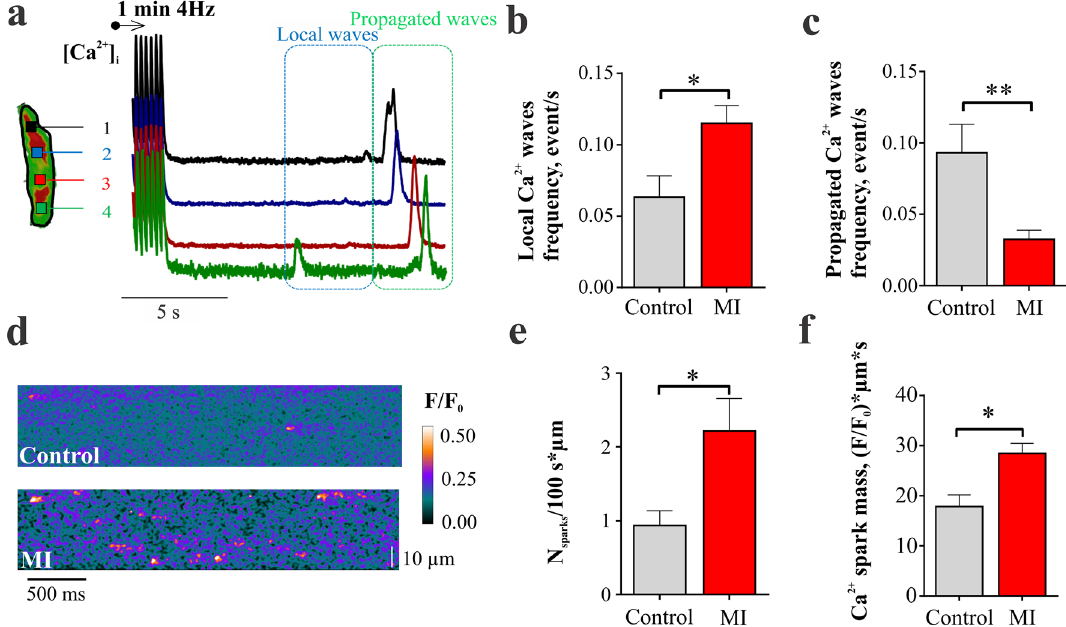
Figure 3. Spontaneous Ca 2+ activity in MI versus control RVMs. (a) Illustration of the spontaneous Ca 2+ waves recorded in control and MI RVMs. Myocytes were paced for 1 min at 4 Hz to enhance SR Ca 2+ loading, then the spontaneous Ca 2+ activity was recorded during 16 s after the pacing cessation. Propagated and local Ca 2+ waves were analysed separately. (b) Analysis of local and (c) propagated Ca 2+ wave frequency in control and MI RVM. Control n = 10 cells from 4 rats, MI n = 13 cells from 4 rats. **P < 0.01, by unpaired Student t test. (d) Line-scan images of Ca 2+ sparks activity in RVMs from control and MI rats. (e) Analysis of average Ca 2+ sparks frequency and (f) mass (amplitude x full width at half maximum x full duration at half maximum) in control and MI RVMs. Control n = 26 cells from 4 rats, MI n = 21 from 4 rats. *P < 0.05, by Mann–Whitney test (frequency) and unpaired Student t test